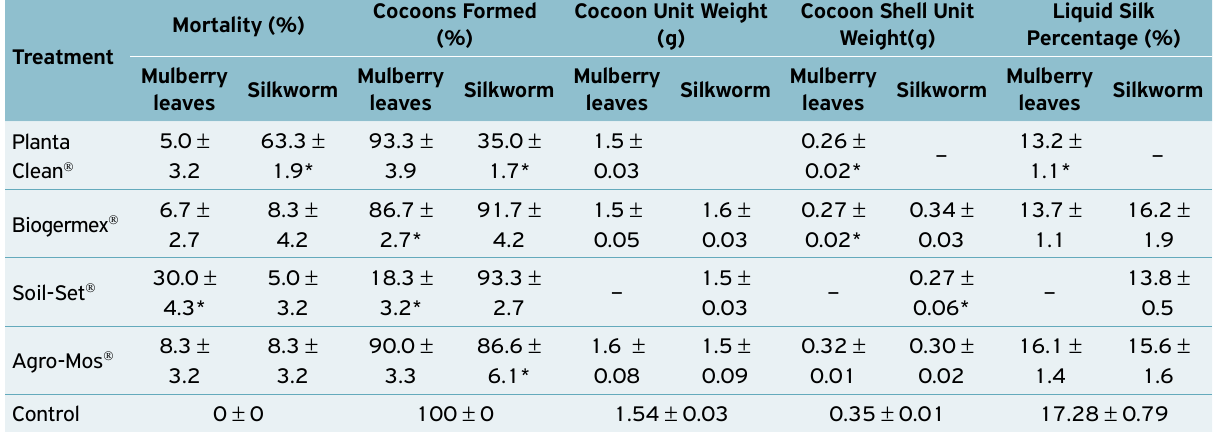
Table 2. Mortality cocoon production, cocoon unit weight, cocoon shell unit weight (g) and liquid silk percentage of B. mori silkworms subjected to treatment with alternative phytosatinary products daily sprayed on mulberry leaves, and on the silkworms for five days (26 ± 1ºC, 12 hour photoperiod and relative humidity of